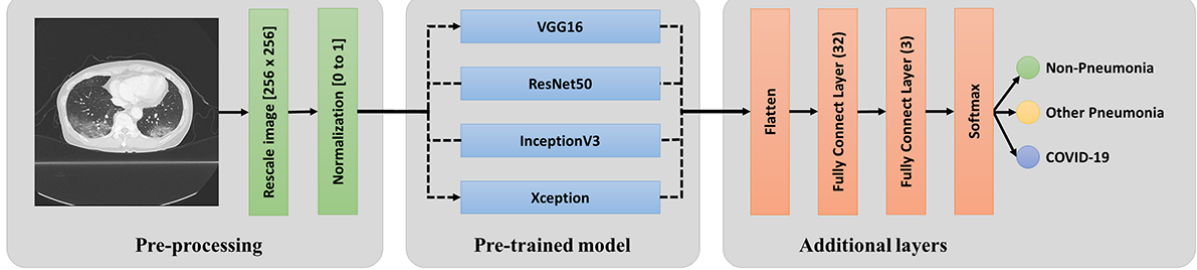
Augmented images for training, n (%)Data source and group